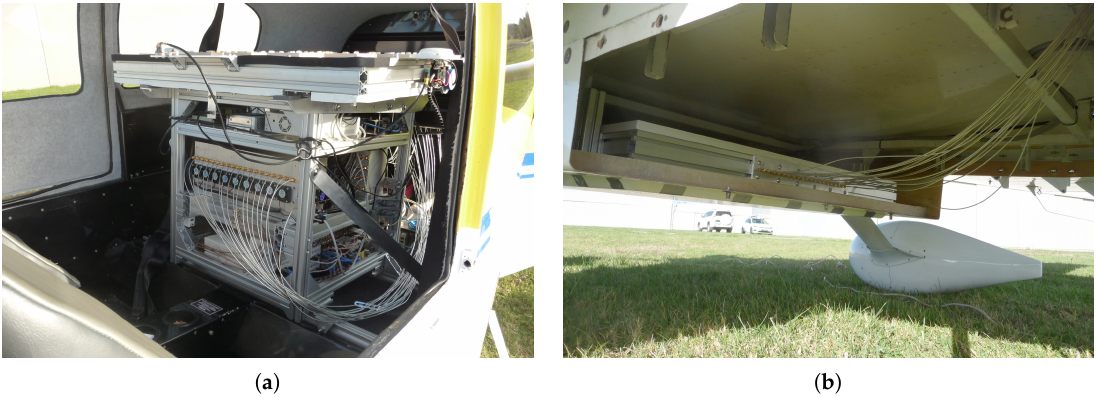
Figure 1. ( a ) Microwave interferometric reflectometer (MIR) instrument and up-looking array mounted inside the airplane, and ( b ) down-looking array covered with a radome hanging from the airplane’s fuselage (with part of the fairing